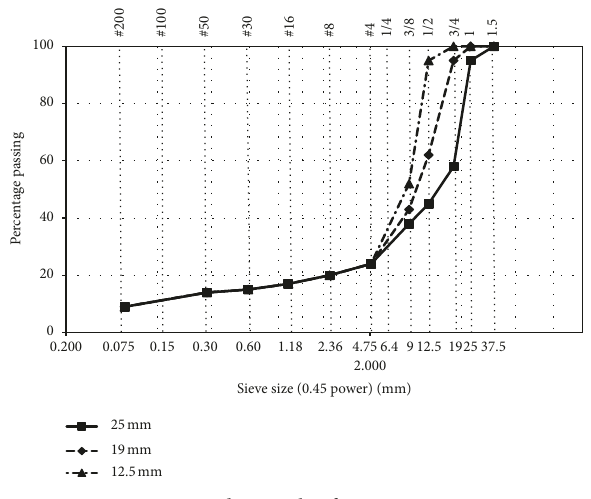
Figure 2: Gradation plot for SMA mixtures.